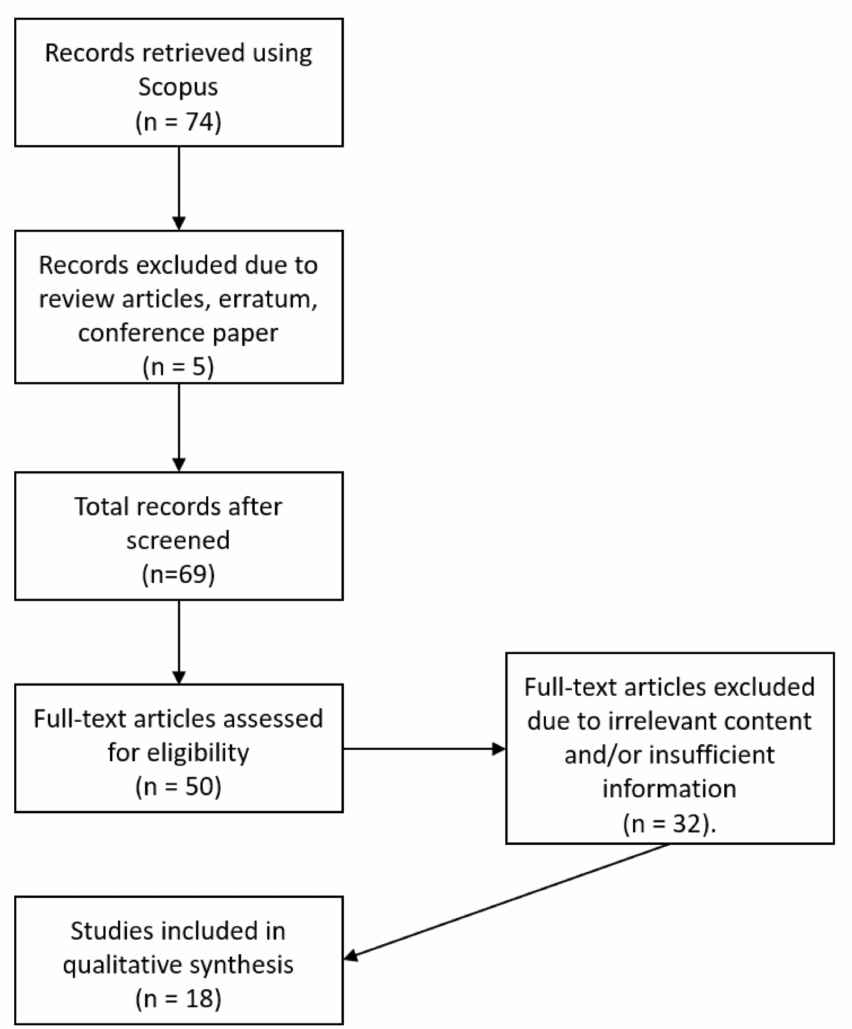
Figure 2. Flow diagram of the systematic review information adopted with modification from